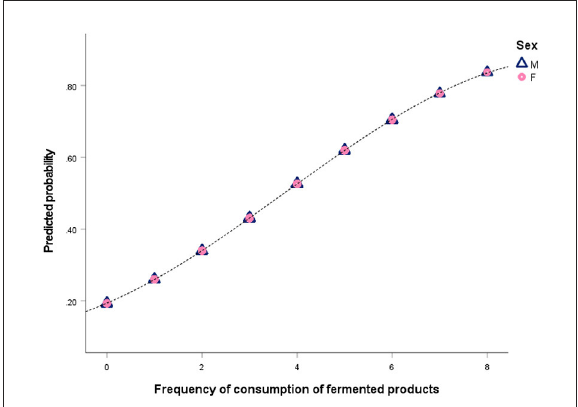
FIGURE1 Predicted likelihood of having a normal anxiety state (STAI score < 40) and consuming fermented foods (yogurt and cheese).